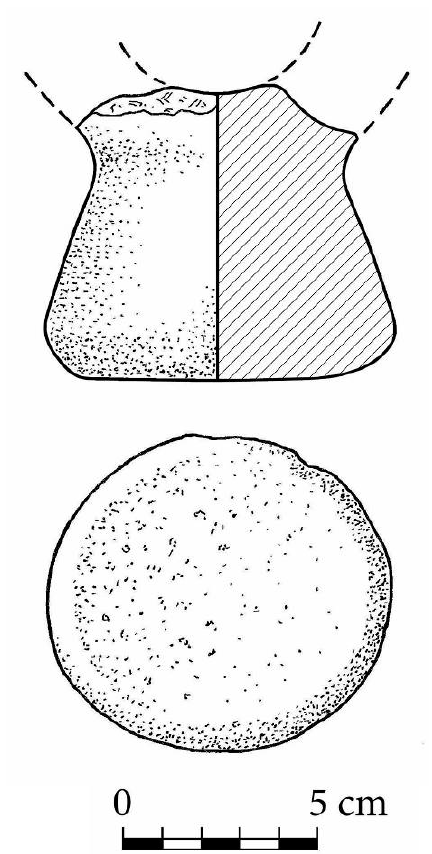
Figure 3. Solid base type. Basket B50/1, locus - topsoil, raw material - basalt, notes - flat solid